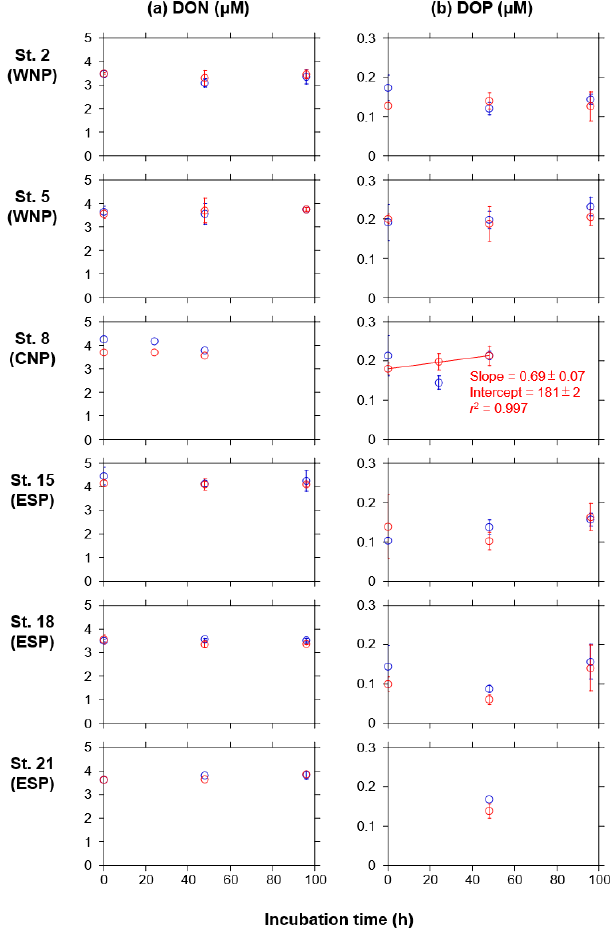
Figure A2. Temporal changes in concentrations of (a) DON and (b) DOP in the control (blue) and treated (red) bottles during the incubation periods at six stations during the KH-11-10 cruise. Error bars denote standard deviations ( n = 3). Duplicate or single data are denoted as mean or single values without error bars. A linear regres- sion line is depicted in the DOP concentrations in the treated bottle at station 8, as a significant increase ( p < 0 . 05) in the mean con- centration against time was observed. Errors of slope and intercept represent 95% confidence intervals.